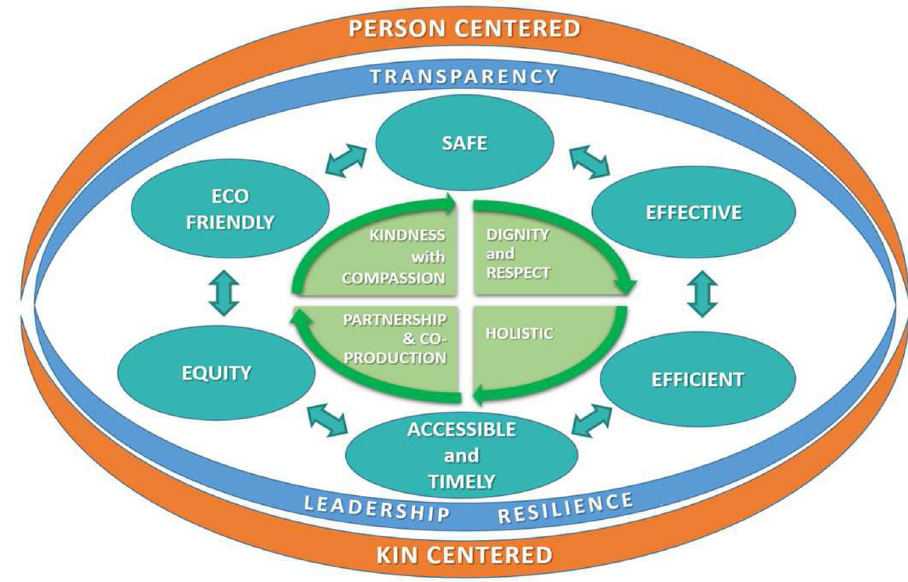
Figure 1. The domains of quality for the new era of